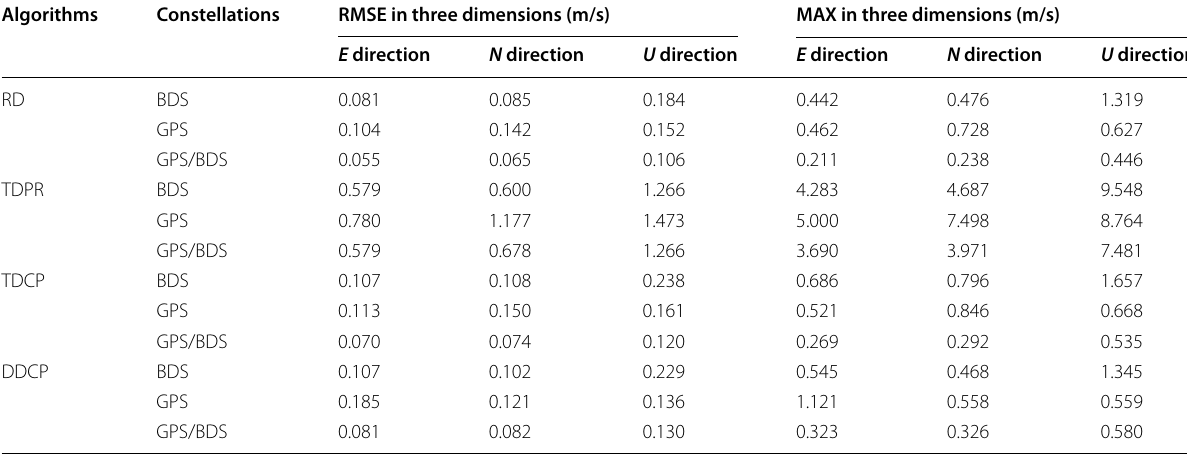
Table 3 A comparison of the obtained velocity accuracies in dynamic test 2 Algorithms